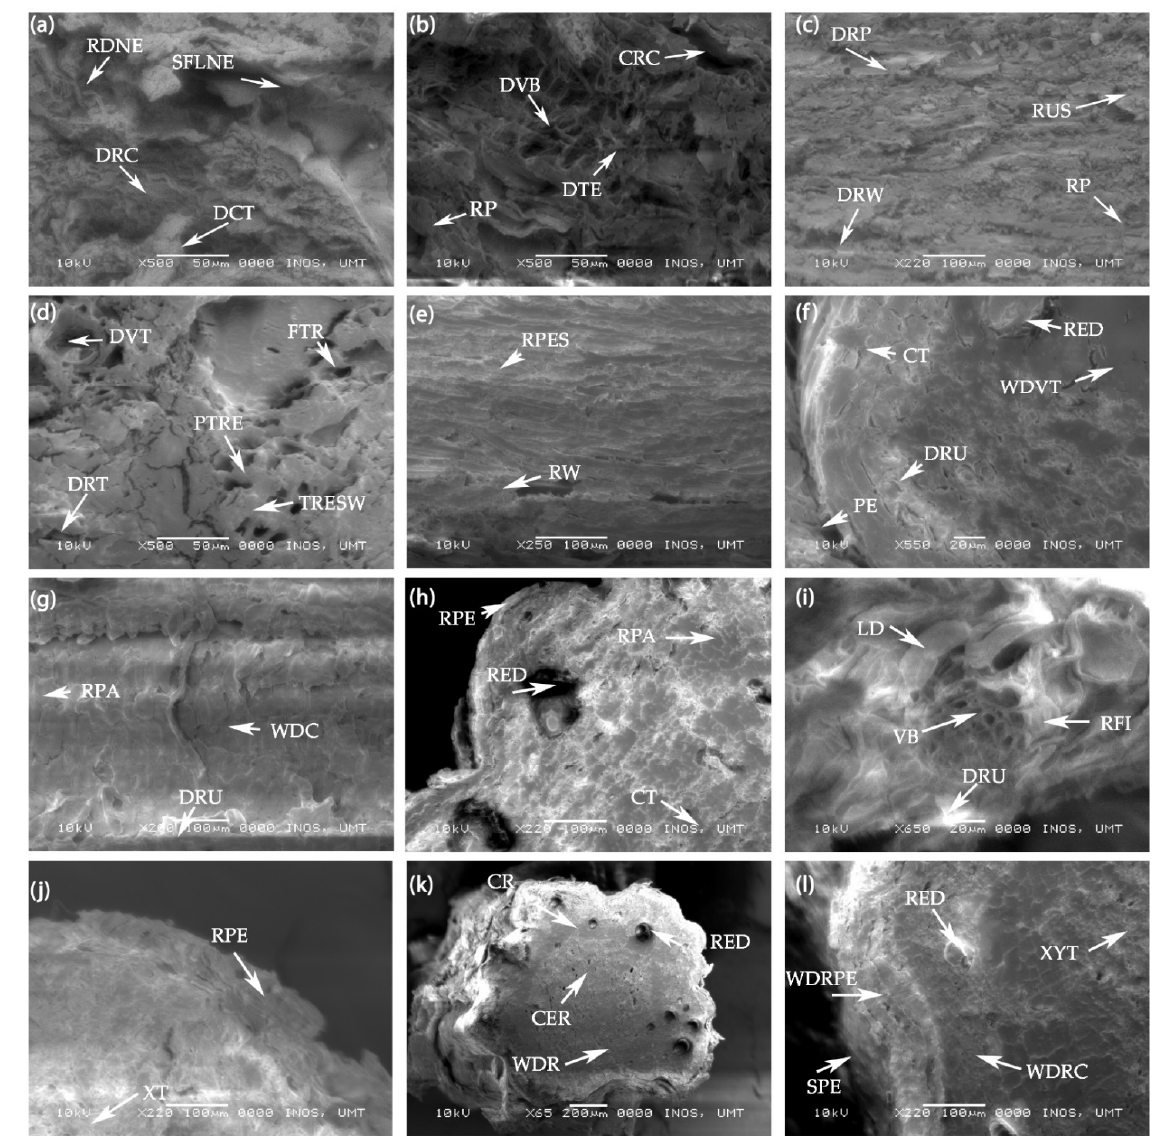
Figure 7. ( a , b ) Scanning electron microscopy (SEM) photographs of the untreated (control) root cross sections of the F. deltoidea plant. The photographs show damaged root cells, dented cortical tissue, ruptured periderm, and damaged vas ‐ cular bundles. The sign of forward locomotion of the nematode and cortical lesion are visible in the roots of the